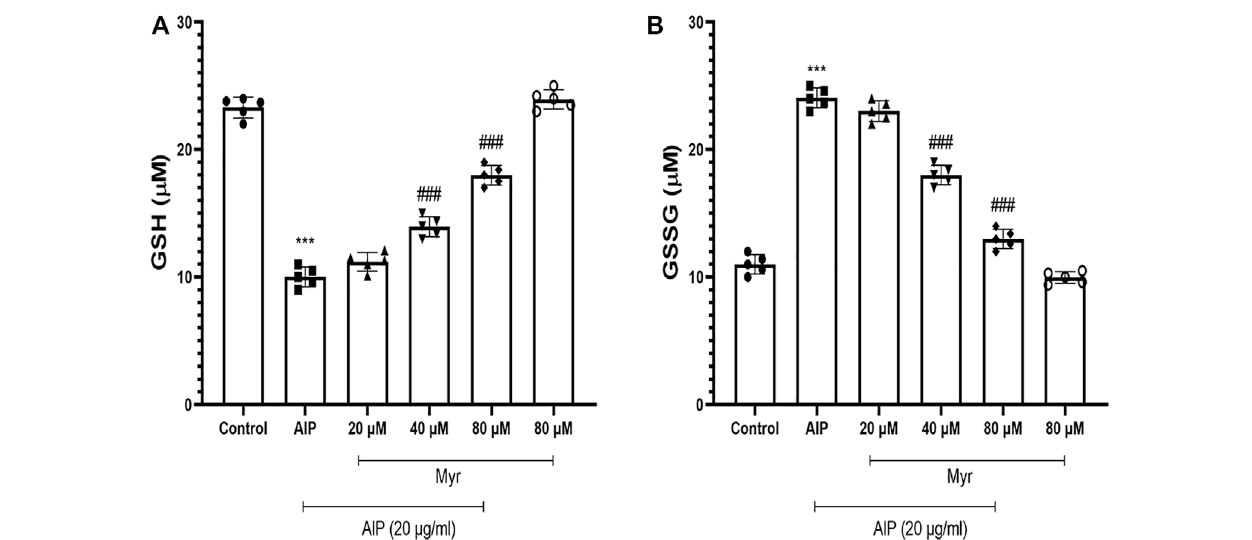
FIGURE 5 | Myr inhibits AlP-induced GSH depletion in isolated cardiomyocytes. Isolated cardiomyocytes were treated or cotreated with the indicated concentrations (20 μ g/ml) of AlP and Myr (20, 40, and 80 µM) for 3 h. GSH and GSSG levels were measured as previously described in the Materials and Methods section. (A) GSH content signi fi cantly decreased AlP-treated isolated cardiomyocytes, while cotreatment of Myr (40 and 80 µM) with AlP obviously increased the GSH content in isolated cardiomyocytes. (B) AlP signi fi cantly increased the GSSG content in isolated cardiomyocytes after 3 h of exposure, while Myr (40 and 80 µM) signi fi cantly decreased the GSSG content in the presence of AlP. Data are mean ± SD ( n (cid:2) 3) of three independent experiments. *** p < 0.001 signi fi cantly different from control, ### p < 0.001 signi fi cantly different from AlP-treated cardiomyocytes, one-way ANOVA, Tukey ’ s test. Myr, myricetin; AlP, aluminum phosphide; GSH, reduced glutathione; GSSG; oxidized